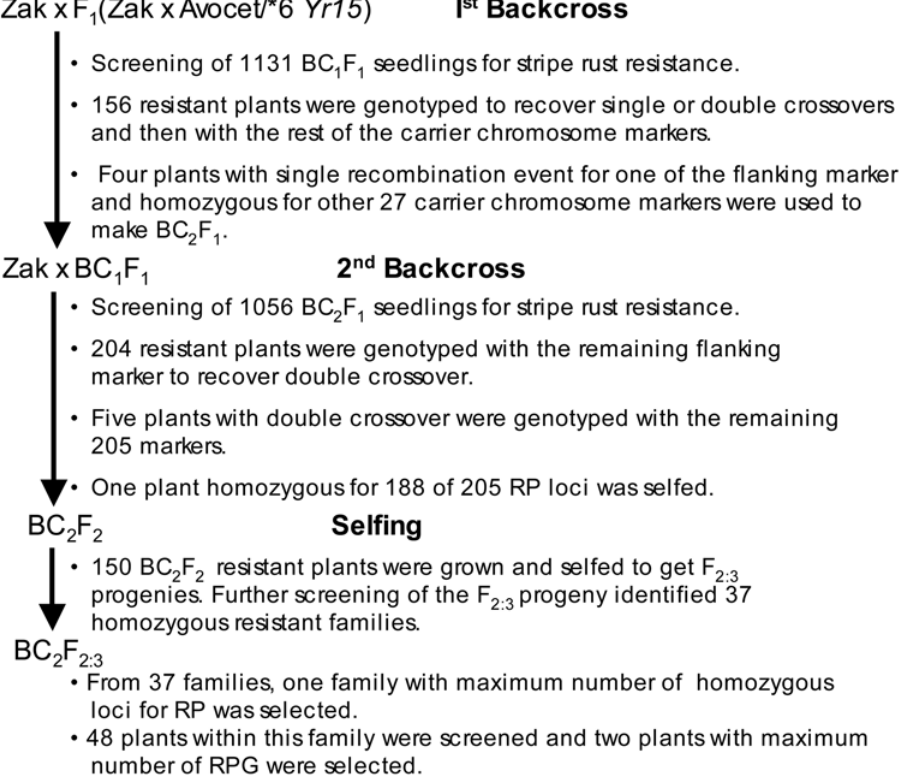
Figure 2. Schematic representation of introgression of stripe rust resistance gene Yr15 into the cultivar ‘Zak’ using MABS.